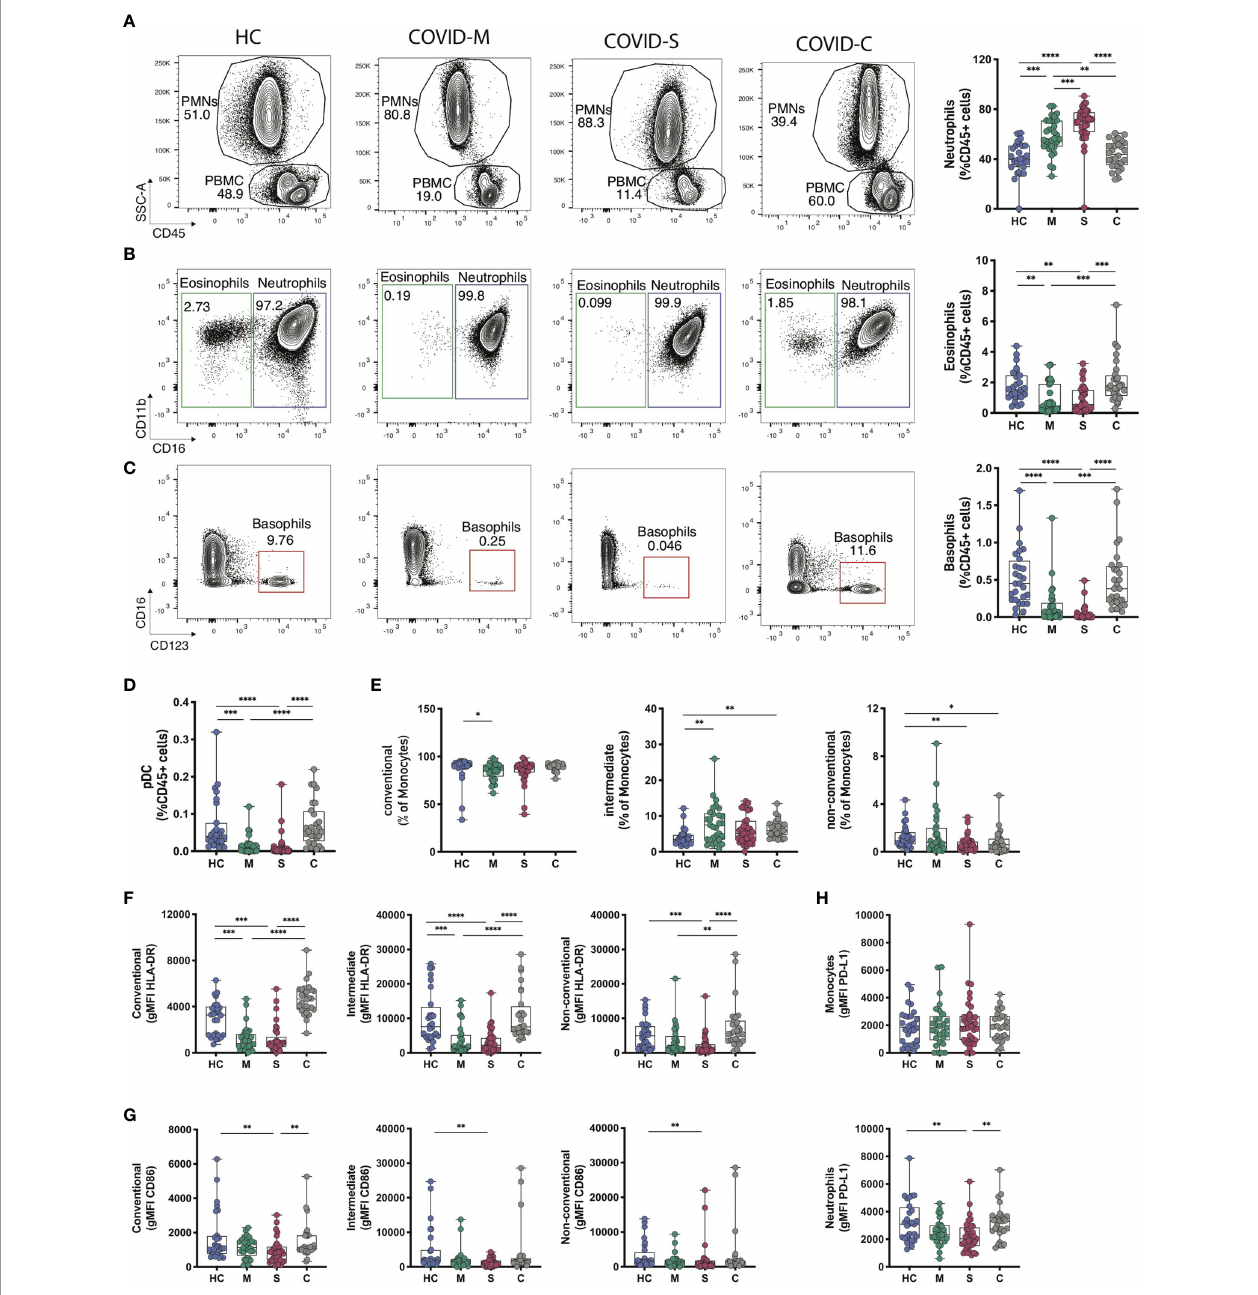
FIGURE 1 | Innate Immune pro fi le of COVID-19 patients. Frequency and phenotype of granulocytes and other innate immune populations were assessed through multiparametric fl ow cytometry analysis of peripheral blood samples of COVID-19 patients with moderate and severe disease, convalescent COVID-19 patients and healthy controls. (A – C) Representative fl ow cytometry plots and frequency of granulocyte populations calculated within CD45 + leukocytes. (A) Polymorphonuclear cells (PMN) and peripheral blood cells (PBMC) gates within CD45 + cells for each subject studied. (B, C) Neutrophils, eosinophils and basophils frequency was assessed for each donor. FACS plots show percentages of each population within the PMN gate (neutrophils and eosinophils) or the PBMC gate (basophils) whilst box plots display cell frequency inside the CD45 + population. (D) Plasmacytoid dendritic cell (pDCs) frequency within the CD45+ population. (E – G) Frequency of conventional, intermediate and non-conventional monocytes subsets found in peripheral blood samples (E) and the mean fl uorescence intensity of HLA-DR (F) and CD86 (G) within the different monocyte subsets. (H) PD-L1 expression levels in neutrophile and monocyte populations of COVID-19 patients and healthy controls. HC = Healthy controls, n = 28; M = COVID-Moderate, n = 29; S = COVID-Severe, n = 37; C = COVID-Convalescent, n = 28. Differences between groups were calculated using Kruskal-Wallis test and Dunn ’ s multiple comparison post-test (*p = 0,05; **p = 0,01; ***p = 0,001; ****p =